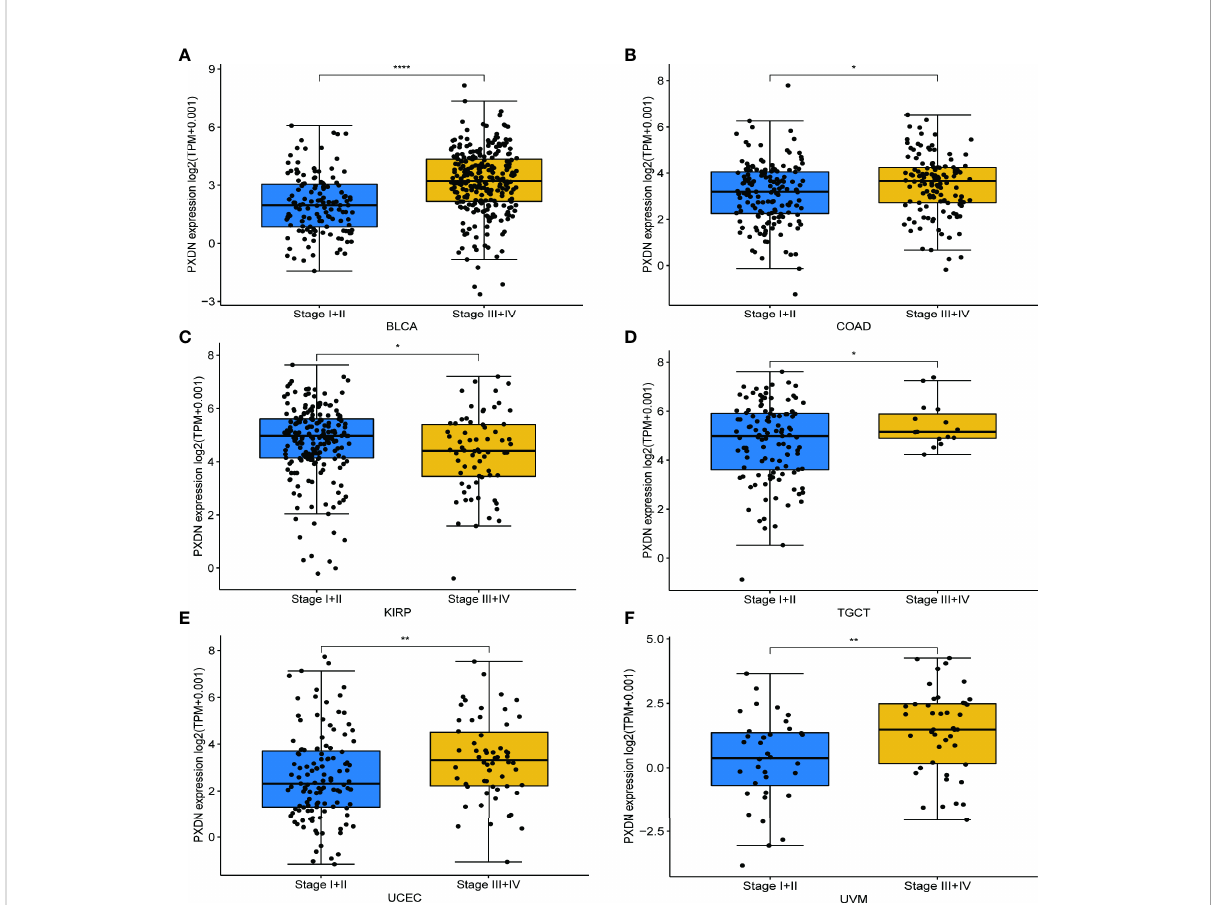
FIGURE 4 Relationship between PXDN expression and different pathological stages. (A – F) Relationship between PXDN levels and different pathological stages of BLCA, COAD, KIRP, TGCT, UCEC, UVM. *p<0.05, **p<0.01,